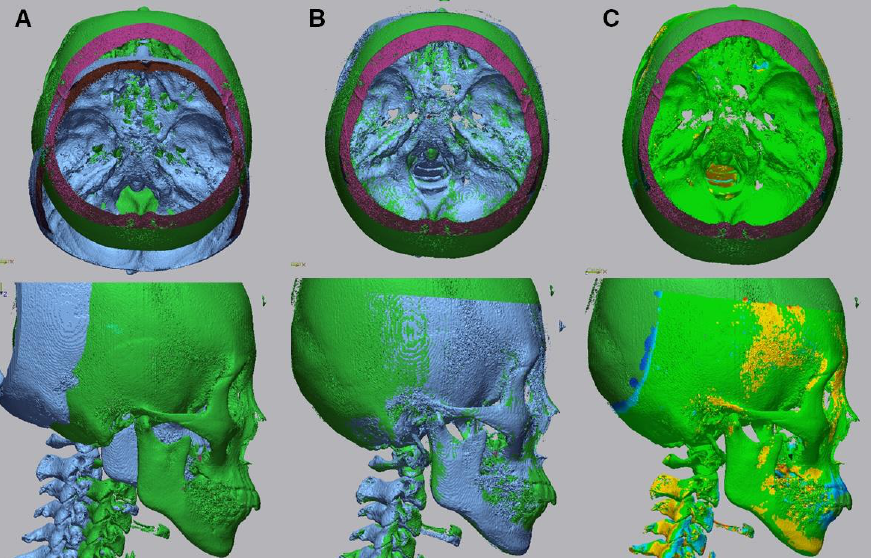
Figure 4. Alignment of the pre-treatment and post-treatment surface data. ( A ), Before superimposi- tion. ( B ), The superimposition process involved the following two steps; (i) initial alignment was performed before running other alignment types. The software automatically calculated an initial fit between the two objects to get the Reference (pre) and Measured (post) data close and register features. (ii) Best fit alignment was then applied to calculate the best fit between the two objects automatically. ( C ), 3D comparison function after alignment.